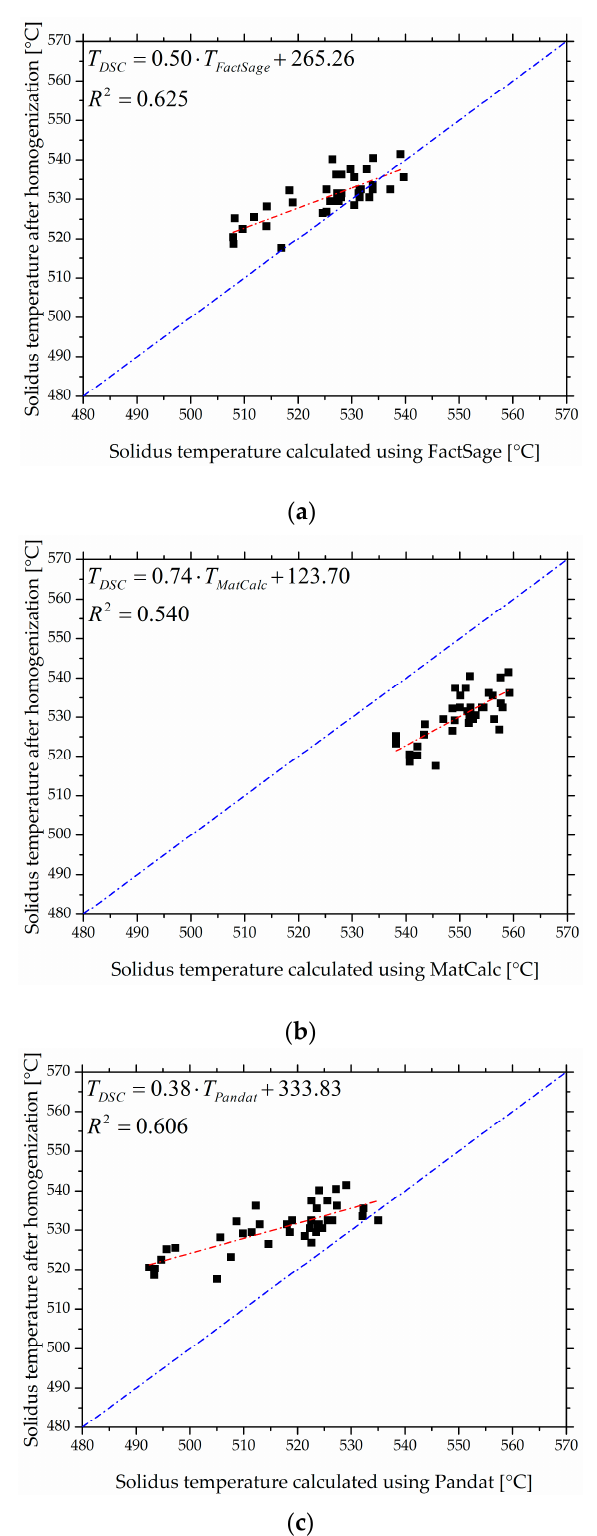
Figure 5. Representation of DSC measurement results compared with thermodynamically predicted forecasts: ( a ) FactSage ® vs. DSC; ( b ) MatCalc vs. DSC; and ( c ) Pandat™ vs. DSC.